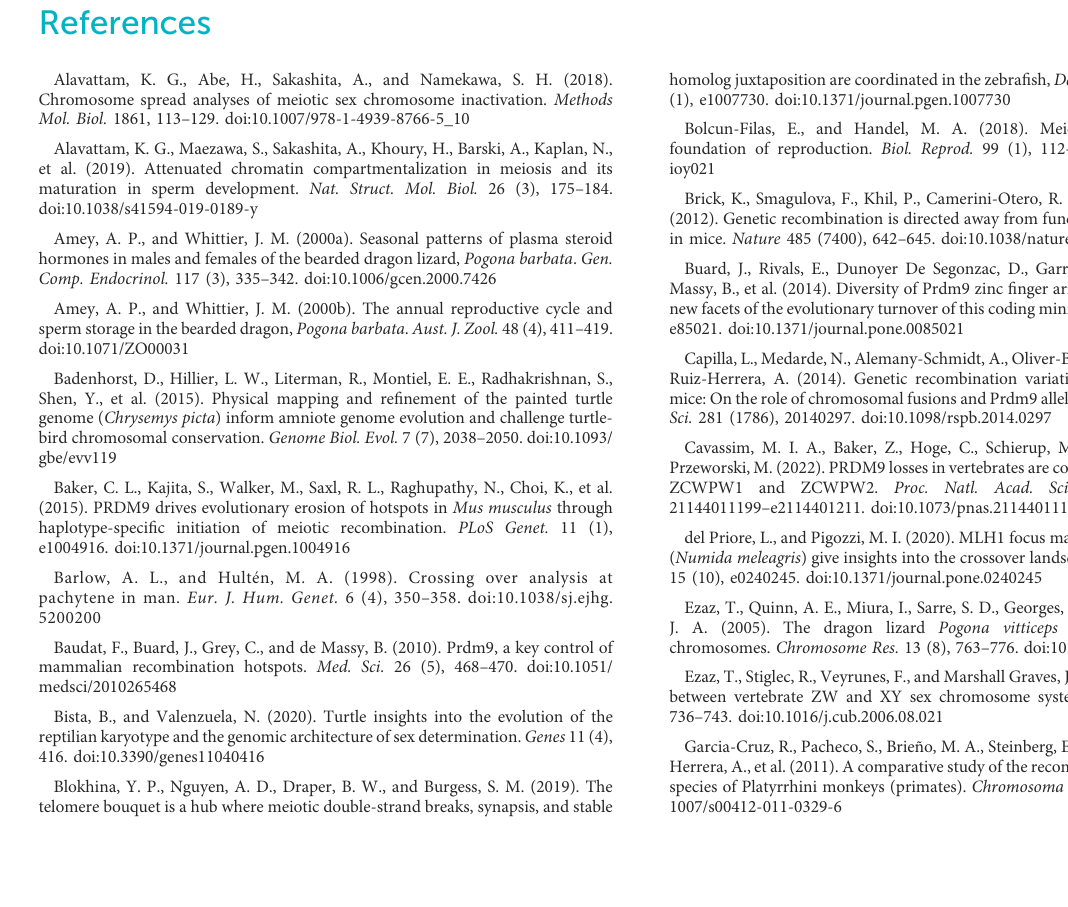
DNA with DAPI (blue) for (A) the western-banded gecko and (B) the painted turtle. Scale bar: 10 μ m. SUPPLEMENTARY FIGURE 2: Telomere dynamics during prophase I. Spermatocyte spreads labelled with antibodies against SYCP3 (green), SYCP1 (red) and TRF2 (blue) for the bearded dragon. Scale bar: 10 μ m and 2 μ m (insets). White arrowheads: telomeres from which SC is beginning to assemble. Yellow arrowheads: completely synapsed micro-chromosomes (i.e., lateral and central elements of the SC completely assembled between both telomeric ends). Insets (bottom row panels) show micro-chromosomes completely assembled. SUPPLEMENTARY FIGURE 3: Transcriptional dynamics during prophase I. Spermatocyte spreads labelled with antibodies against SYCP3 (green) and RNApol II (red) for (A) the bearded dragon, (B) the ocelot gecko, (C) the western banded gecko and (D) the painted turtle. Scale bar: 10 μ m. SUPPLEMENTARY FIGURE 4: RPA dynamics during reptilian prophase I. Spermatocyte spreads labelled with antibodies against SYCP3 (green) and RPA (red), counterstaining the DNA with DAPI (blue) for (A) the western banded gecko, (B) the ocelot gecko and (C) the bearded dragon. Scale bar: 10 μ m. SUPPLEMENTARY FIGURE 5: RAD51 dynamics during reptilian prophase I. Spermatocyte spreads labelled with antibodies against SYCP3 (green) and RAD51 (red), counterstaining the DNA with DAPI (blue) for (A) the painted turtle, (B) the ocelot gecko and (C) the bearded dragon. Scale bar: 10 μ